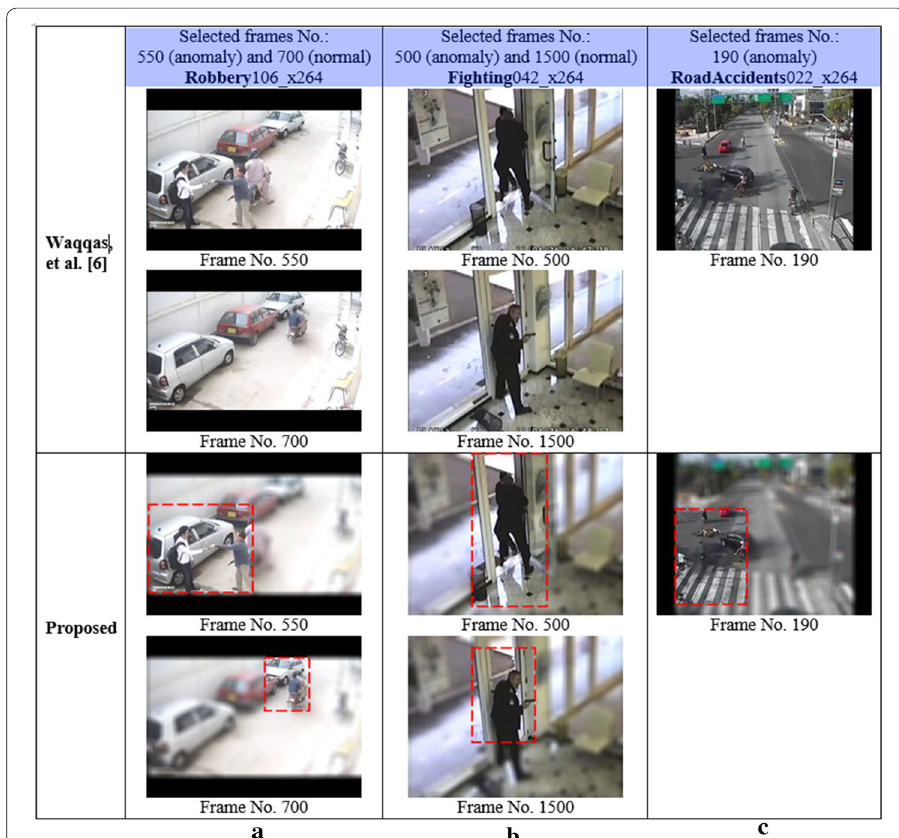
Fig. 10 Corresponding highlighted frames from Fig. 9 in higher resolution and clear illustration of the localized region from the proposed method. a – c show videos containing robbery, fighting, and road accident, respectively